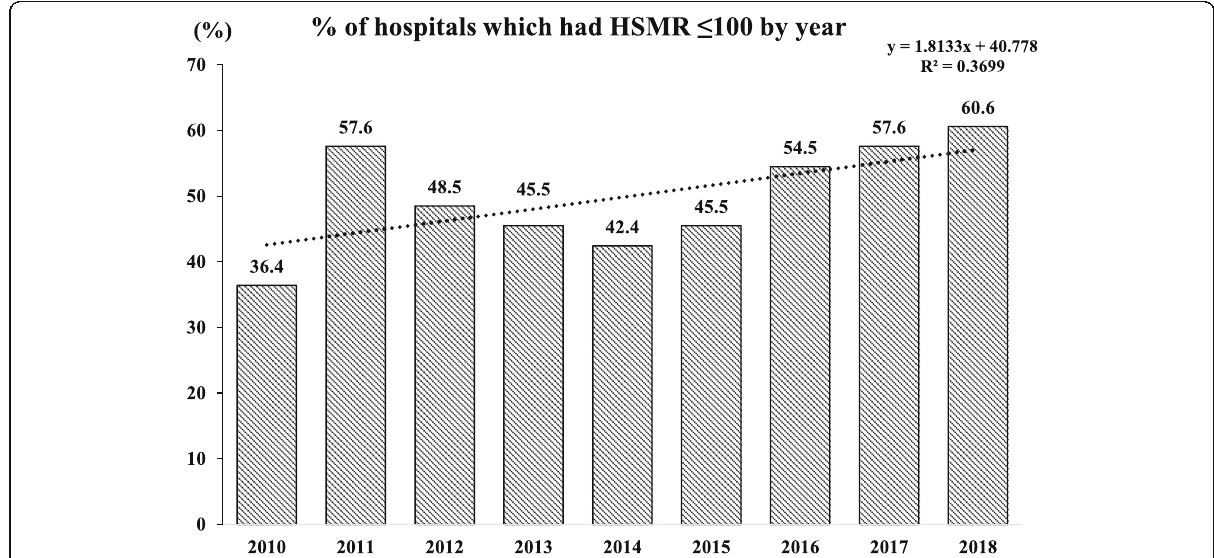
Fig. 2 Trend changes in the percentage of hospitals with HSMR ≤ 100 from 2010 to 2018. Nine-year model, n = 33. HSMR hospital standardized mortality